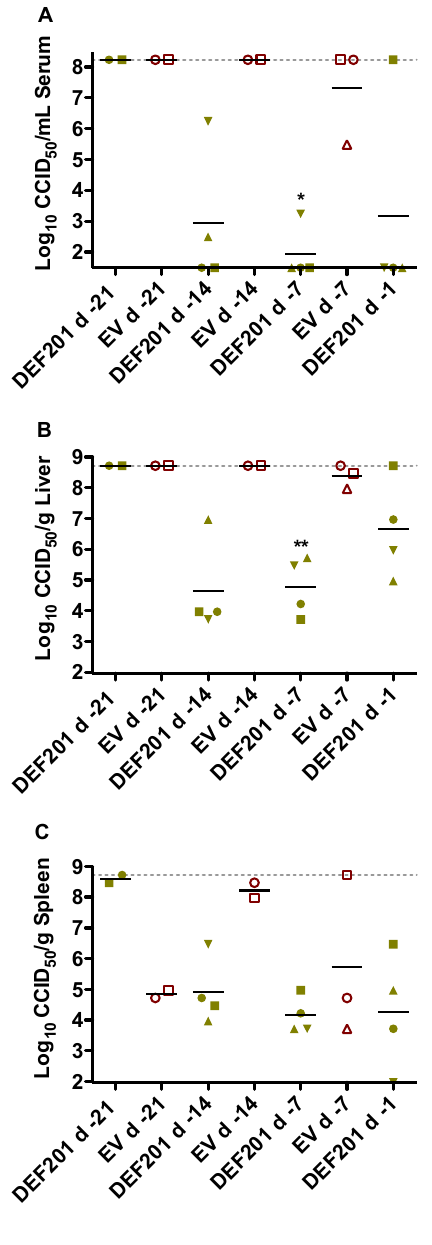
Figure 3. Reduced viral titers associated with protective effect of DEF201. Subgroups of hamsters (n = 4/group) treated and infected in parallel to the animals in the observation groups described in Figure 1 were sacrificed on day 2 post-infection for analysis of ( A ) serum, ( B ) liver, and ( C ) spleen virus titers. Unique symbols in each treatment group represent values for the same animal across all parameters. Several groups have less than 4 data points due to death prior to time of sacrifice. Two animals in the DEF201 d −21 group and nine animals in the EV groups (including all of the d −1 group) succumbed prior to day 2. The gray hashed lines represent the saturation level indicating that actual titers are equal to or greater than the plotted concentration. * p < 0.05, ** p < 0.01 compared to respective EV